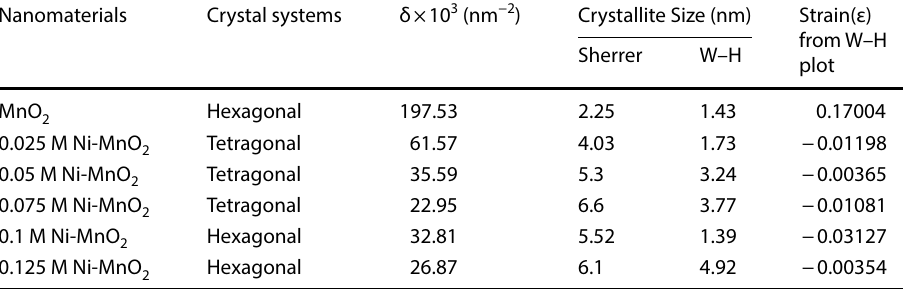
Table 1 Computed microstrain and crystallite parameters from XRD data study of MnO and 2 Ni-doped MnO NPs